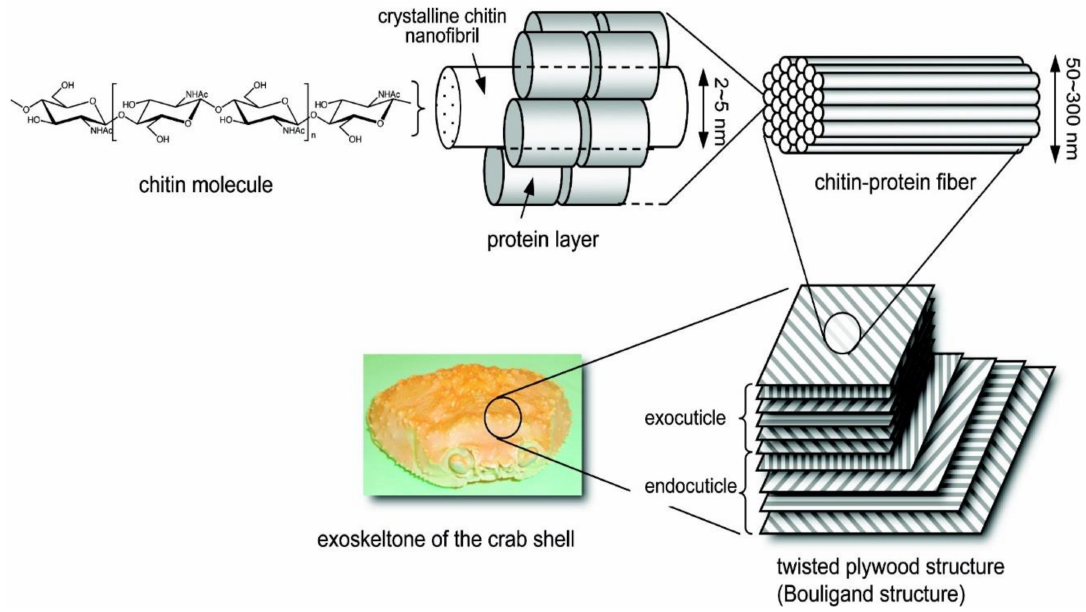
Figure 8. Schematic representation of the exoskeleton structure of crustacean shell. Reproduced with permission from ref. [48]. American Chemical Society,